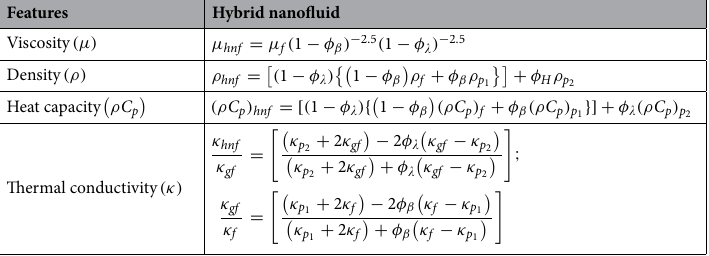
Table 2. Thermo-physical features regarding hybrid nanofluids.